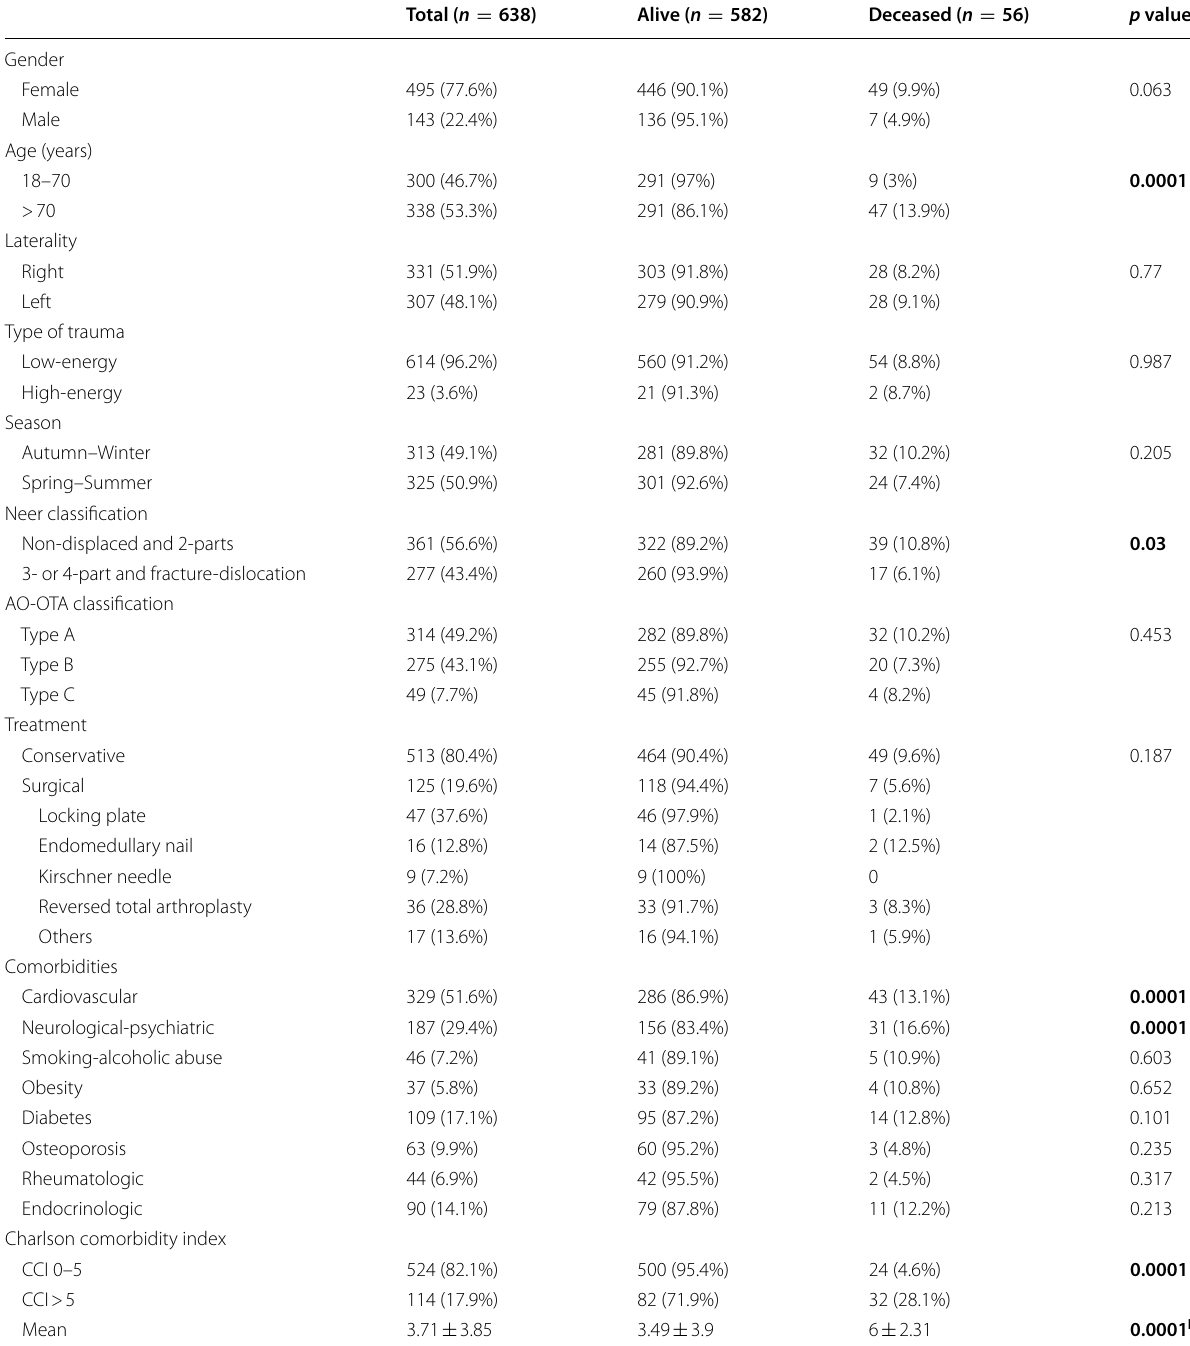
Table 1 Sociodemographic characteristics and differences between